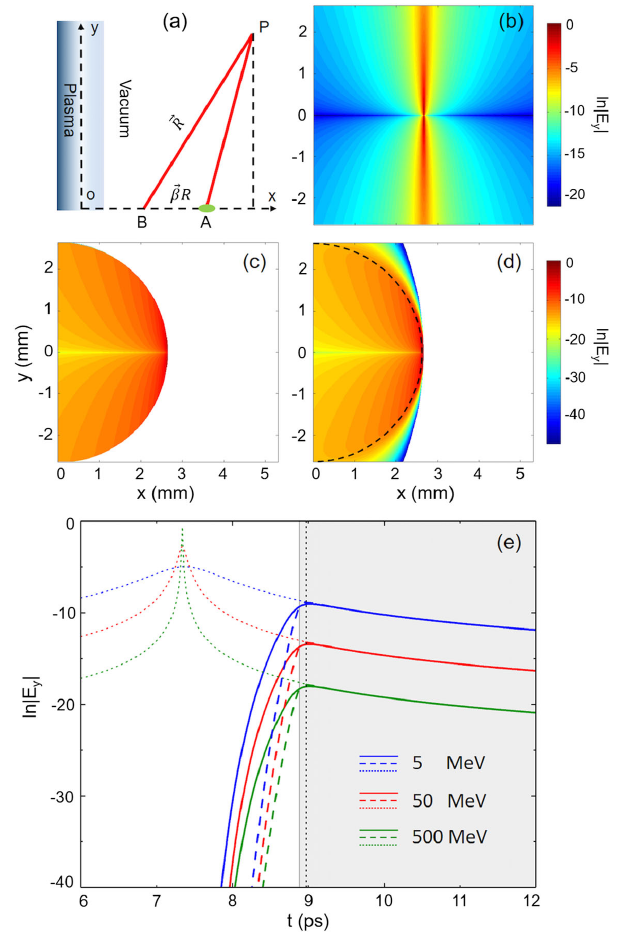
FIG. 6. Discussion on fields structure. (a) is the calculation scheme. (b – d) are the CF spatial distributions of a 10 MeV electron propagating in free space (b), passing through shields with skewness of 1 μ m (c) and 250 μ m (d), respectively. In (e), the temporal profiles of the CFs are plotted at the detection point for an electron with an energy of 5 MeV (blue), 50 MeV (red), and 500 MeV (green). The solid and dashed lines denote the field profiles of the electron passing the plasma shield with skewness of 250 μ m and 100 μ m. The original CF temporal profiles in free space are plotted as colored dotted curves. The grey area shows the region inside the “ light front ” . The dotted black line illustrates the timing of the peak of the CFs for the σ ¼ 250 μ m